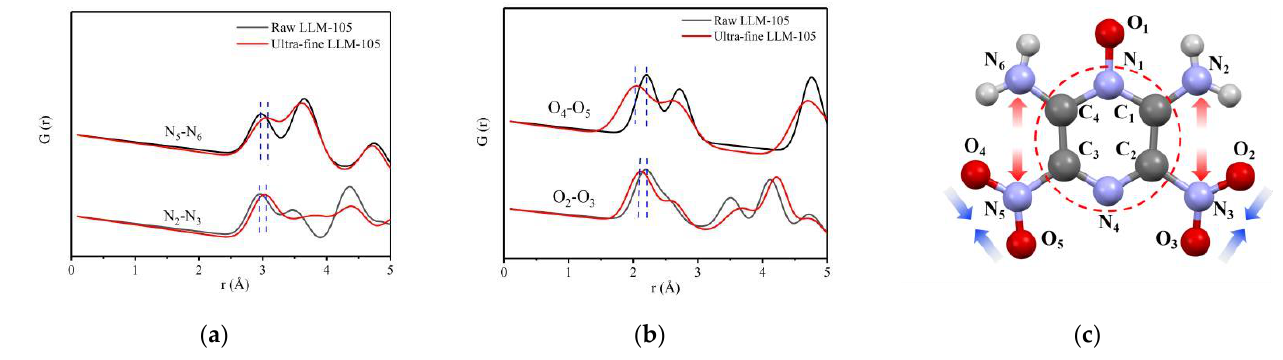
Figure 5. ( a ) PDF curve of N—N atom pair in LLM-105; ( b ) PDF curve of O—O atom pair in LLM-105; ( c ) Schematic diagram of changes of atomic pairs in LLM-105 molecule.